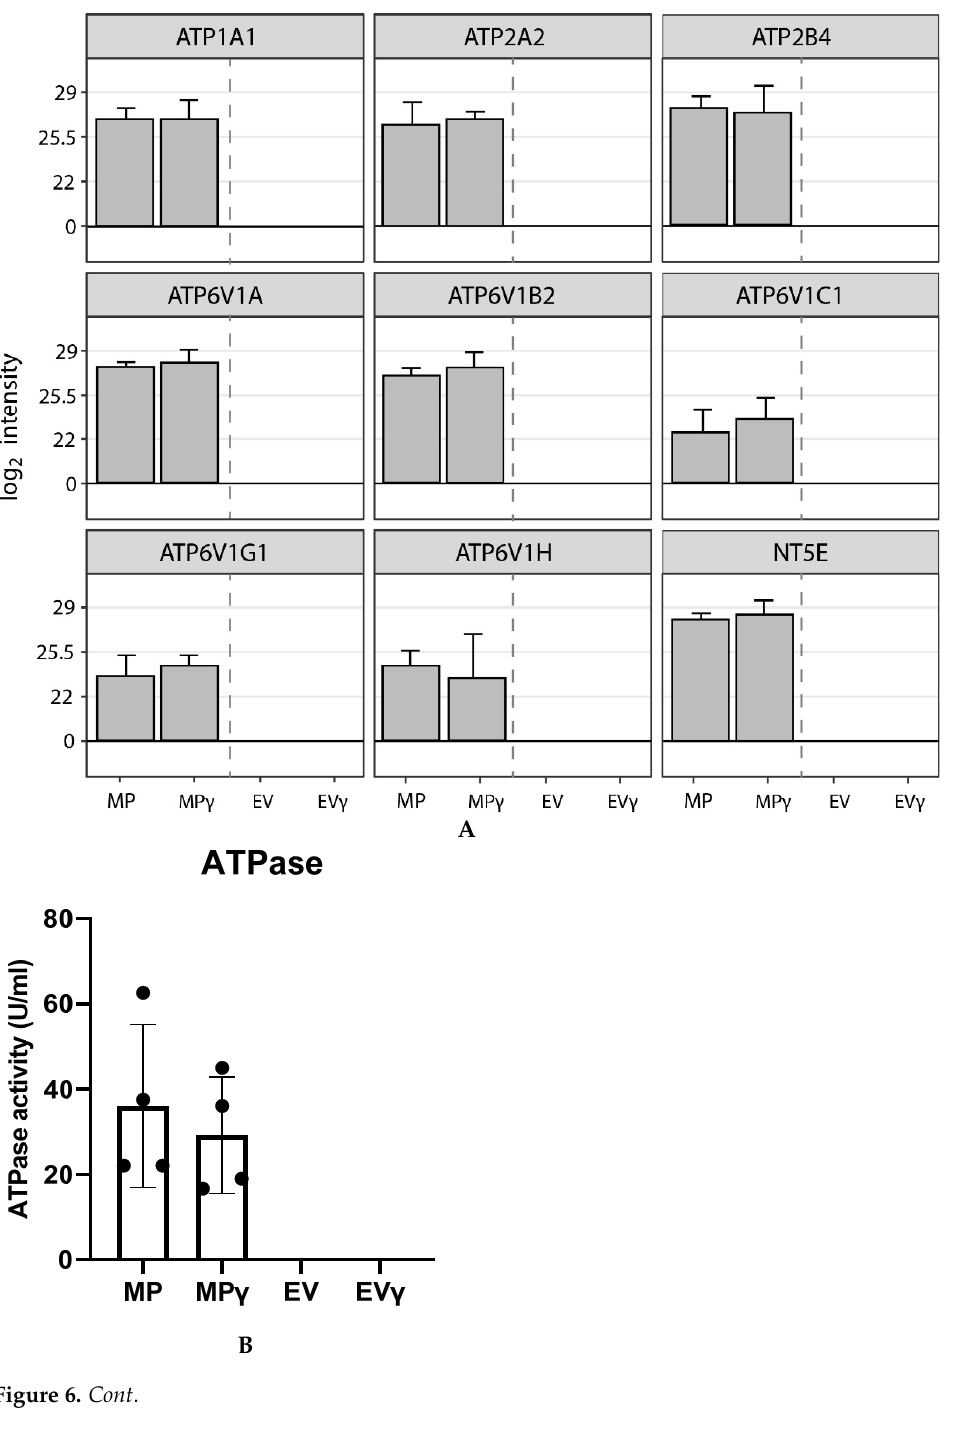
C Figure 6. Enzymatic activity of EV and MP. ( A ): Relative abundance of 8 types of ATPases and ecto-5 ′ nucleotidase in EV, EV γ , MP and MP. ( B ): ATPase activity was measured at a concentration of MP and EV of 1 × 10 11 particles/mL. MP and MP γ catalyzed the breakdown of ATP at similar efficiency, whereas no activity was not observed for EV. ( C ): Ecto-5 ′ - nucleotidase activity was measured at a concentration of MP and EV of 1 × 10 11 particles/mL. MP and MP γ catalyzed the breakdown of AMP at similar efficiency, whereas no activity not observed for EV. 3. Discussion EV are recognized as a promising, but poorly understood, potential therapeutic prod- uct for treatment of inflammatory and degenerative disease [24,25]. MSC constitutively secrete EV and are relatively easy to isolate and expand to large numbers in culture and may therefore be applied as EV factories [26]. However, the collection of therapeutic amounts of MSC derived EV, free from contamination by soluble factors, is a big chal- lenge. Furthermore, we have currently little knowledge on how to modulate the pheno- type and function of MSC derived EV. We therefore generated particles from the mem- branes of human adipose tissue derived MSC by lysing MSC, removal of the nuclei, and subsequent rearranging of the collected membranes through extrusion. The yield of these reconstructed membrane particles (MP) per MSC was 25,000 times higher than of EV, which in terms of quantity, positions MP as a more feasible product for therapy develop- ment than EV.